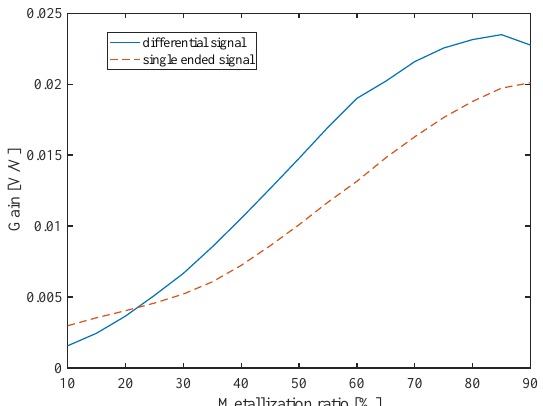
Figure 12. Device gain of single-ended and differential mode for metalization ratios ranging from 10% to 90% operating in mode